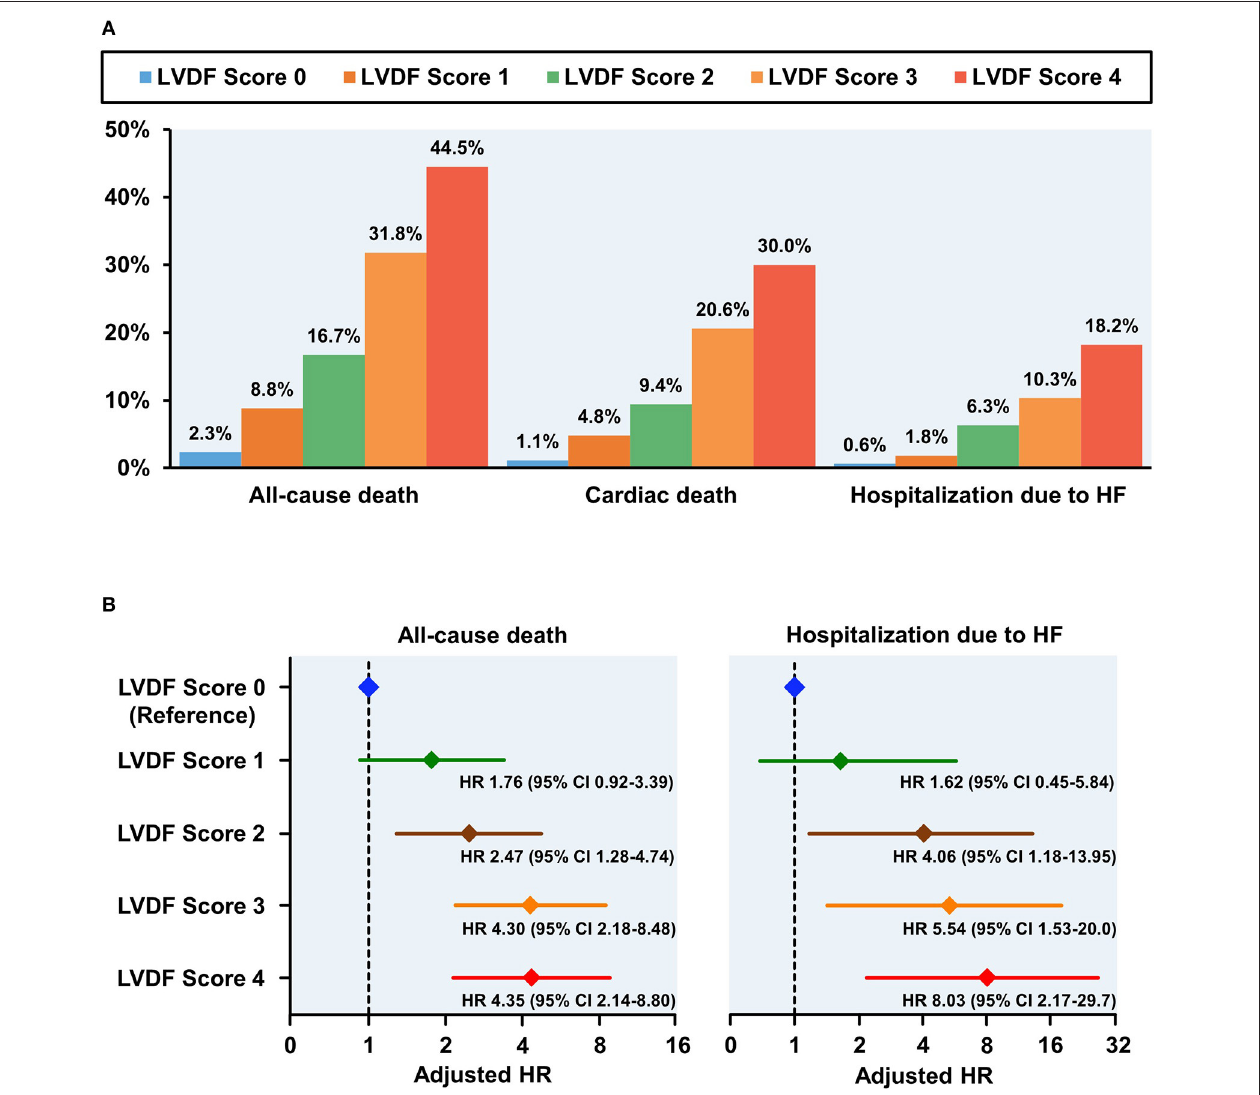
FIGURE 2 | Clinical outcomes according to LVDF scores (A) and adjusted HR plot for all-cause mortality and hospitalization due to HF (B) . All-cause mortality, cardiac death, and heart failure (HF) rehospitalization rates increased in a stepwise fashion from 2.3% (LVDF score 0) to 44.5% (LVEF score 4) ( p < 0.001). Higher LVDF scores had incrementally higher adjusted HRs for all-cause mortality and hospitalization due to HF. CI, confidence interval; HF, heart failure; HR, hazard ratio; LVDF, left ventricular diastolic function.